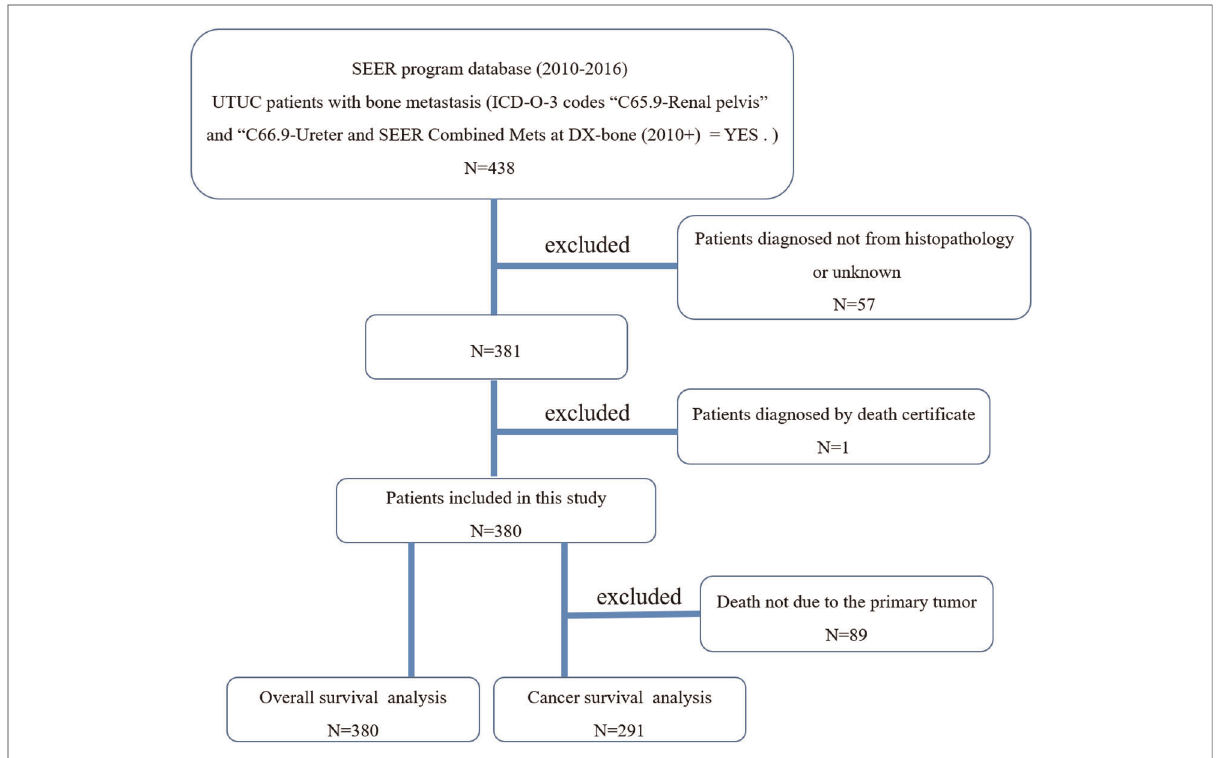
FIGURE 1 The fl ow chart for selection of study population. (SEER, Surveillance, Epidemiology, and End Results; ICD-O-3, international classi fi cation of diseases for oncology, 3rd edition; UTUC, upper-tract urothelial